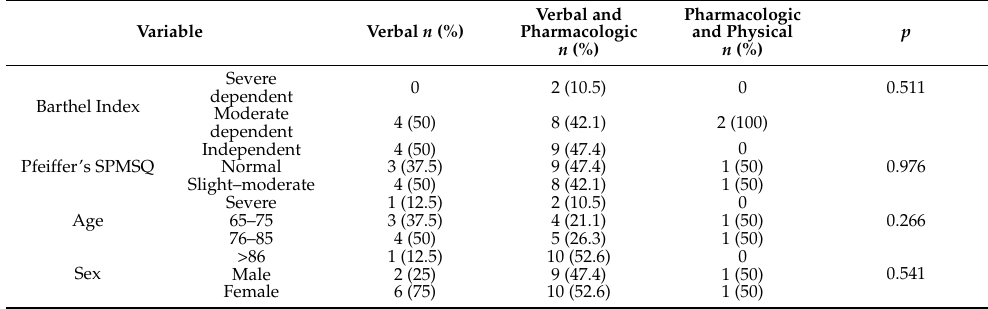
Table 4. Association between management of ADOP and functional and cognitive deterioration, age, and